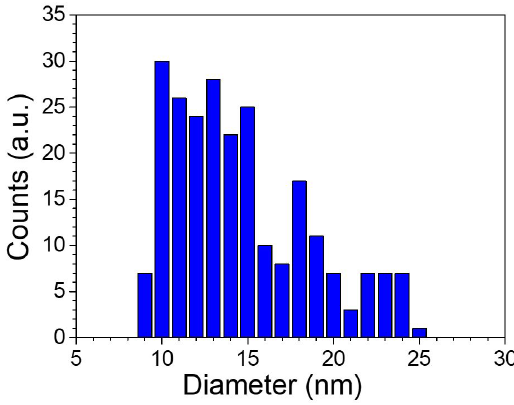
Figure 6. Si-NPs diameter distribution over the PMF-Si